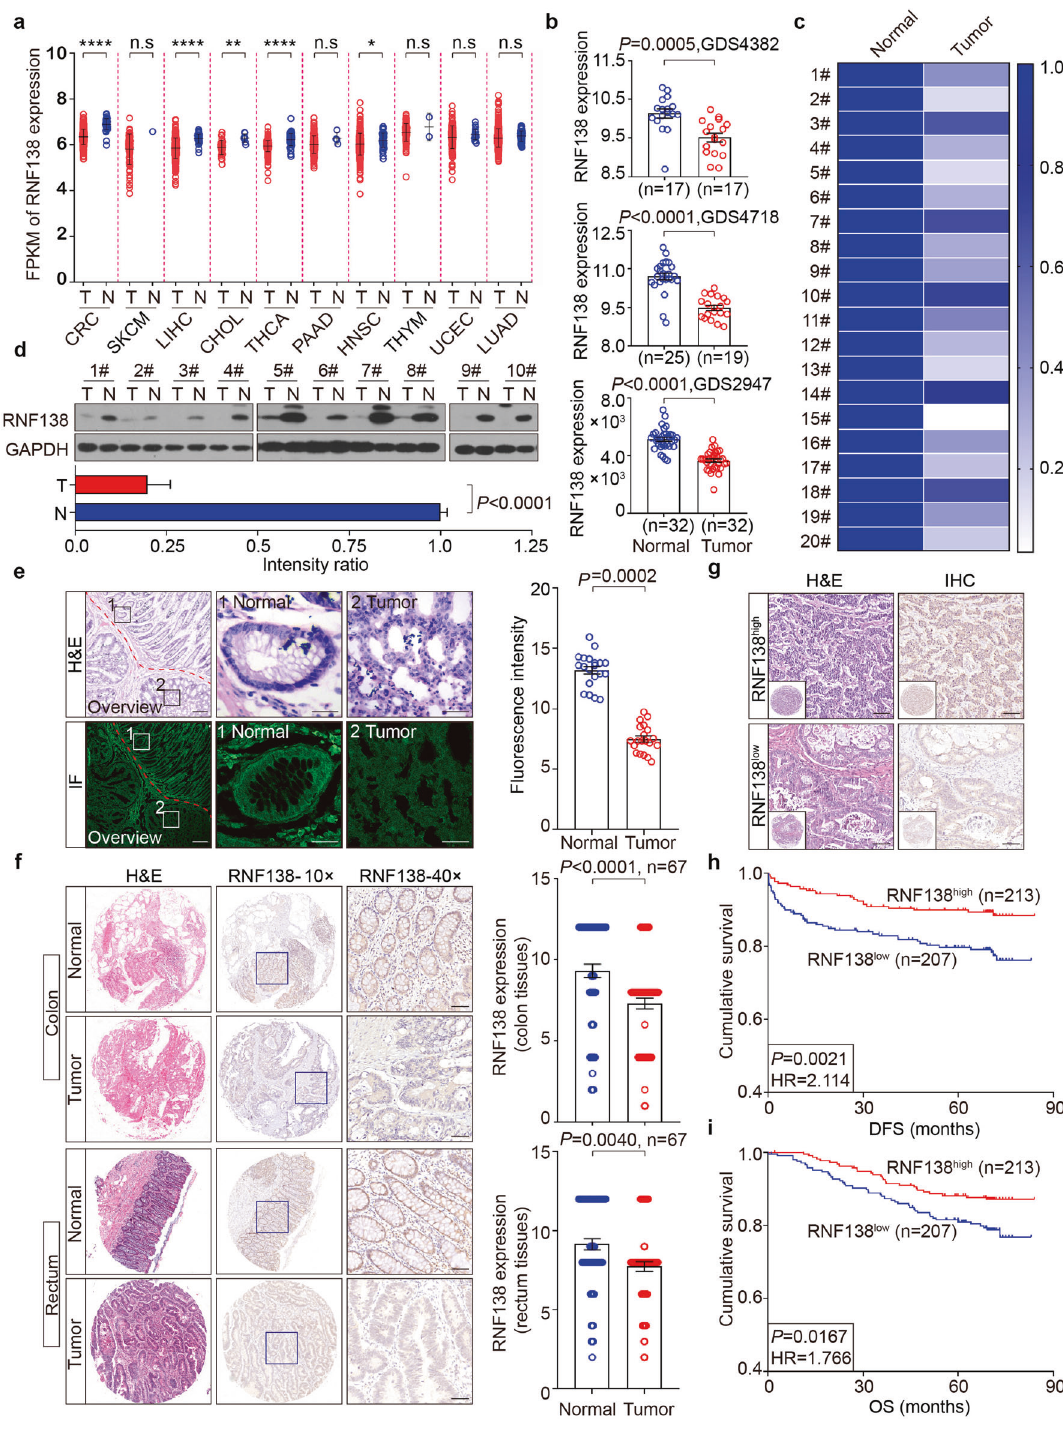
Fig. 1 Downregulation of RNF138 in CRC tumors correlates with poor prognosis. RNF138 mRNA levels in 10 cancer types in the TCGA database ( a ) and three independent GEO datasets ( b ). T tumor tissues, N normal tissues. n.s. not signi fi cant; * P < 0.05; ** P < 0.01; **** P < 0.0001. c Heatmap depiction of RNF138 mRNA levels assessed by qPCR in 20 CRC samples. d Immunoblots and quanti fi cation of RNF138 in 10 CRC samples. e H&E and IF staining for RNF138 and DAPI in a representative CRC sample. Dashed white line represents the boundary between normal and neoplastic tissues. Histogram (right) shows the quanti fi cation of RNF138-staining in CRC or adjacent normal tissues ( n = 20). Scale bar, 20 μ m. f H&E and RNF138-staining in 134 CRC tissues (top, colon tissues, n = 67; bottom, rectum tissues, n = 67). Histograms show quanti fi cation of RNF138-staining in CRC and adjacent normal tissues (right). Scale bar, 100 μ m. g Representative H&E and RNF138-staining images in high and low RNF138 expression in 420 CRC TMAs. The inset box shows an overview of the specimen staining. Scale bar, 25 μ m. Kaplan – Meier survival curves showing the correlation between RNF138 expression and DFS ( h ) or OS ( i ) in 420 CRC samples